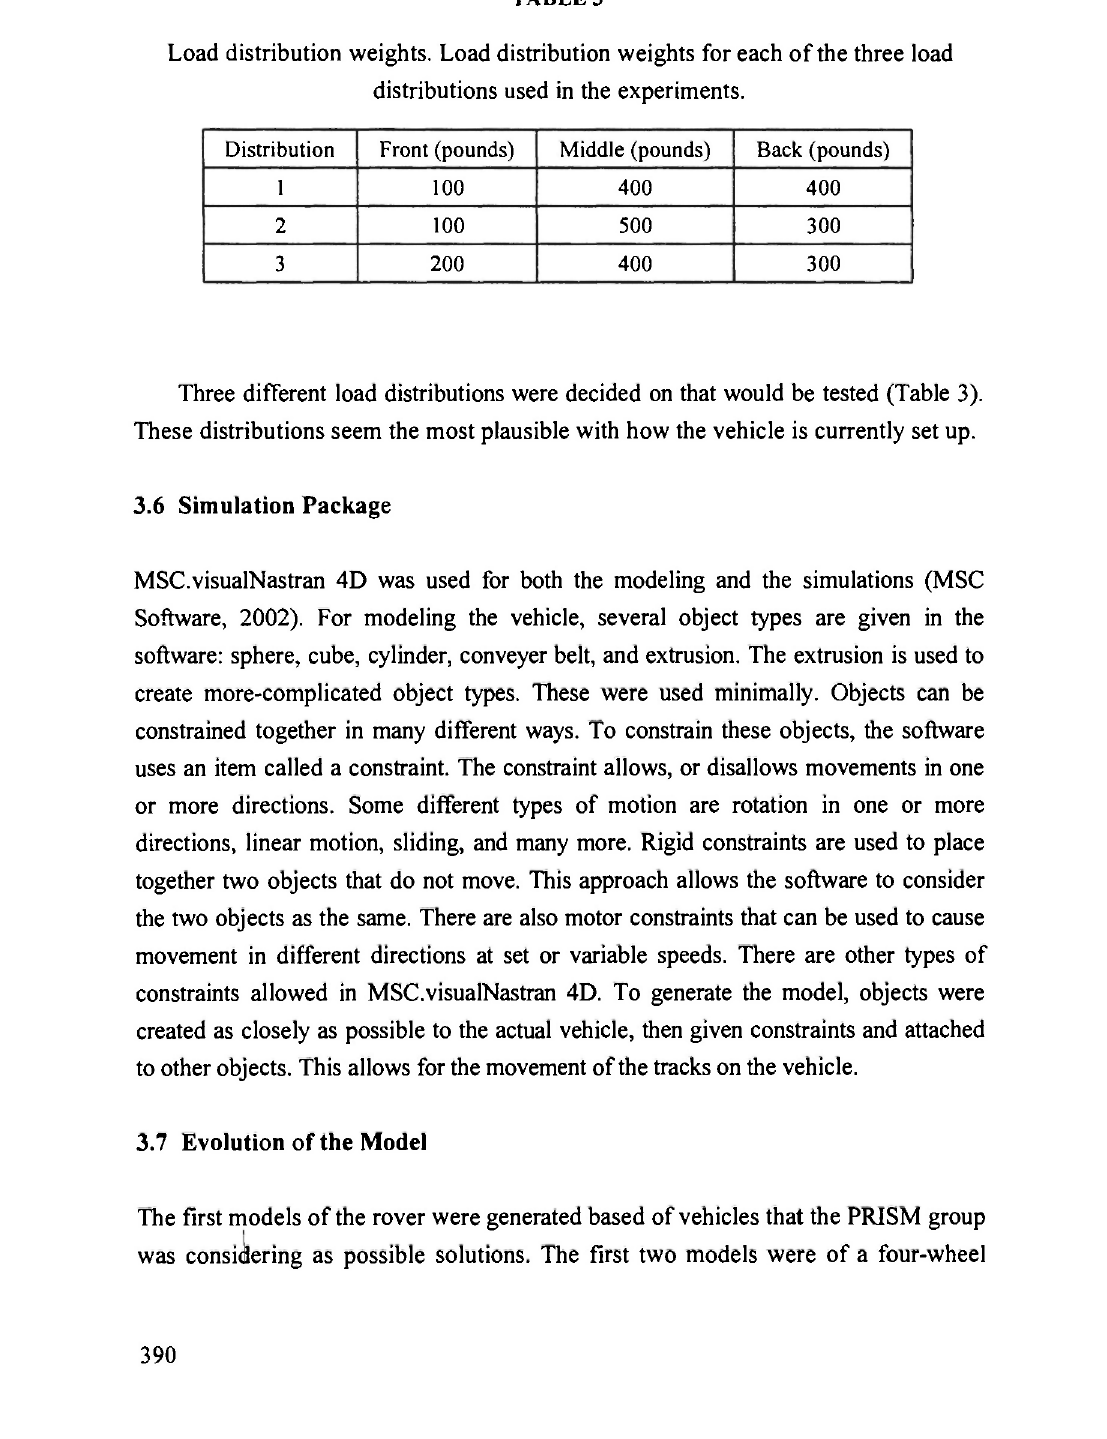
Load distribution weights. Load distribution weights for each of the three load distributions used in the